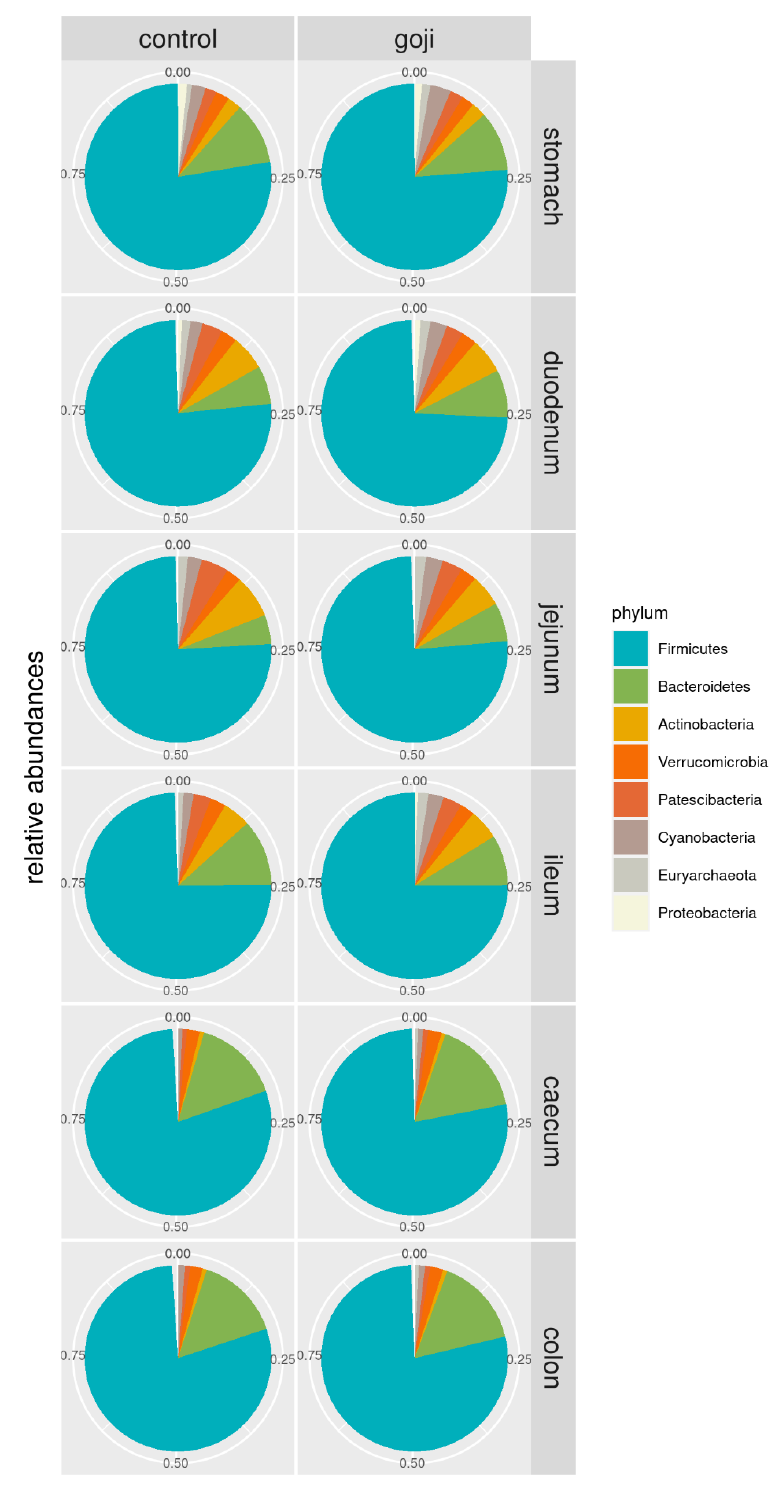
Figure 1. Pie-chart of phylum relative abundances in control and Goji-treated rabbits along the gastrointestinal tract. For the analyses, 14 and 13 samples were used for the control and Goji groups, respectively.